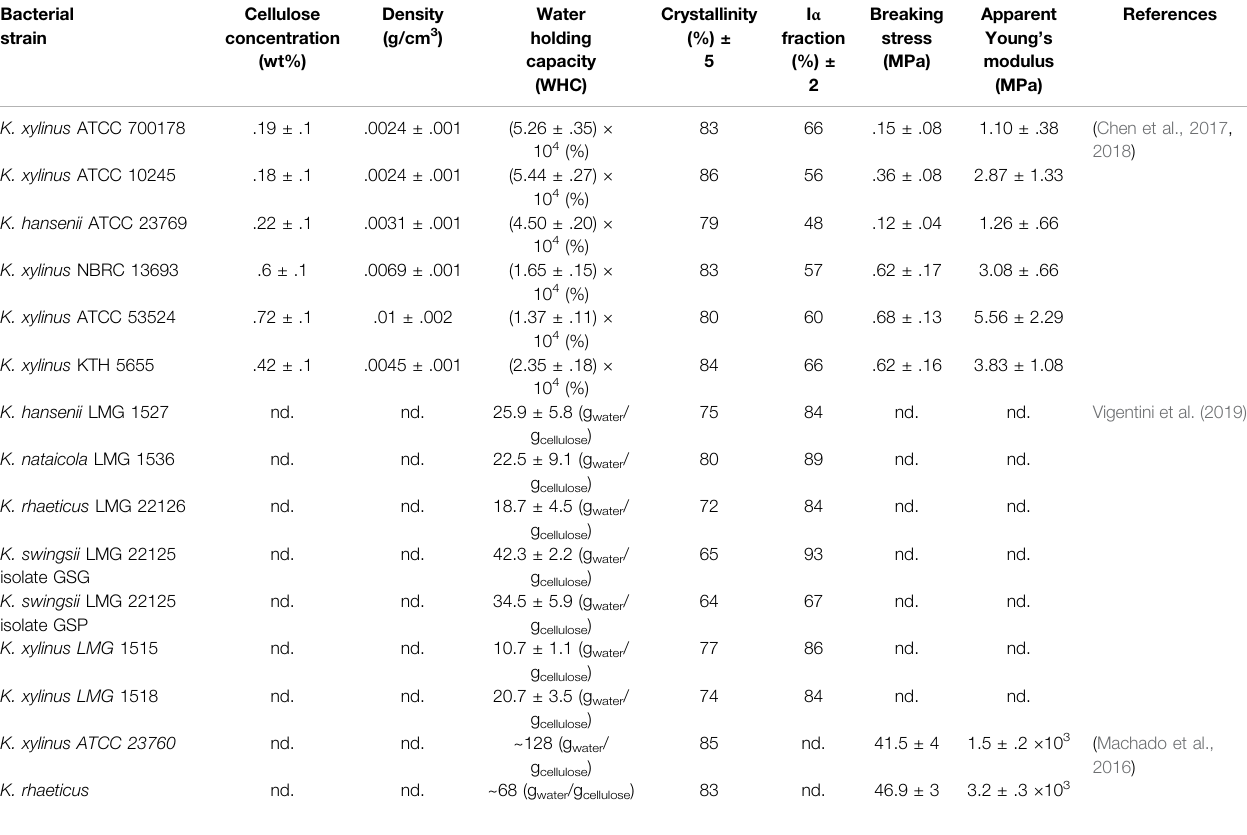
TABLE 1 | Characteristics of BC produced by different strains of Komagataeibacter genus. Bacterial